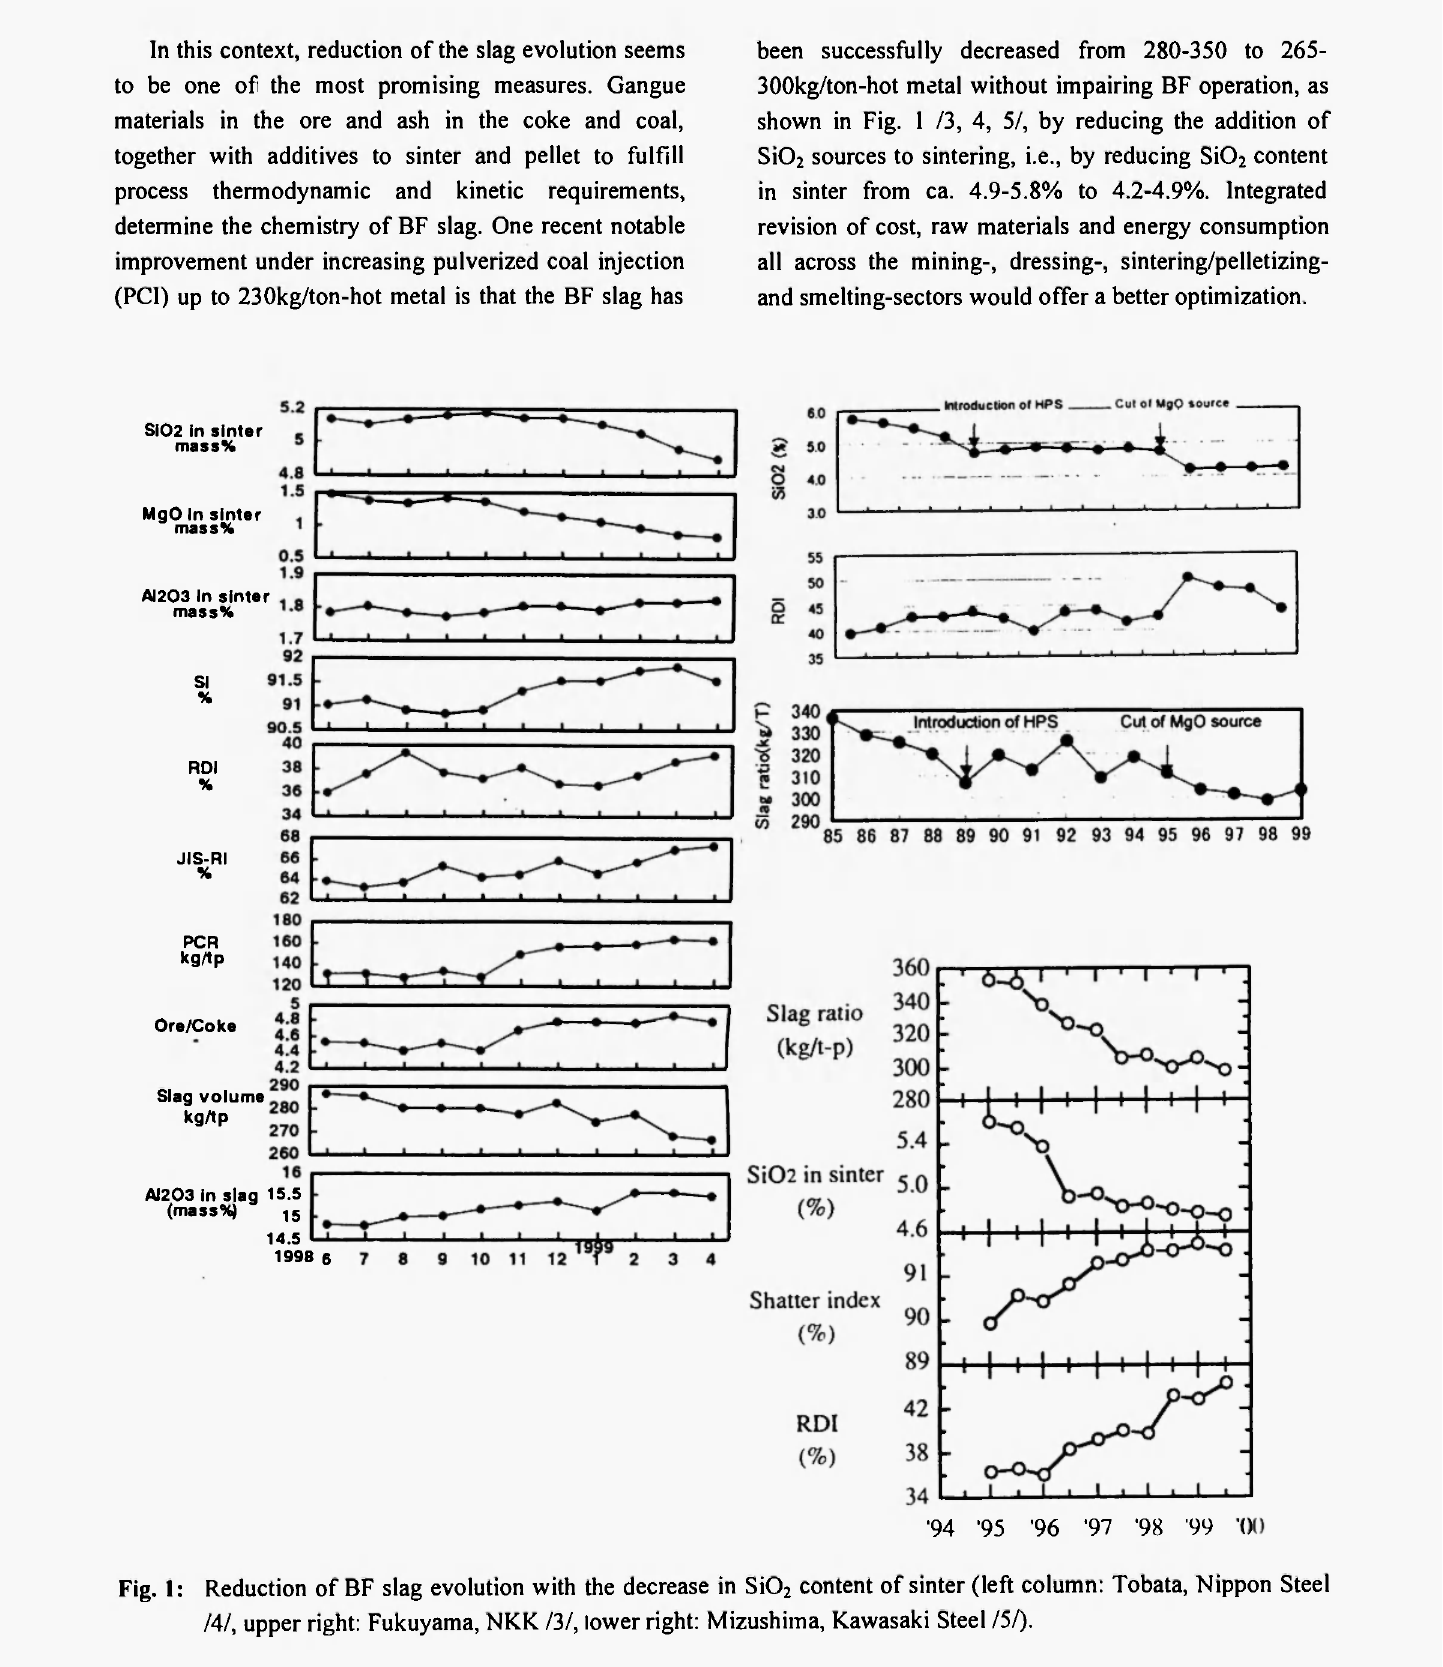
Fig. 1: Reduction of BF slag evolution with the decrease in Si0 2 content of sinter (left column: Tobata, Nippon Steel /4/, upper right: Fukuyama, NKK. /3/, lower right: Mizushima, Kawasaki Steel